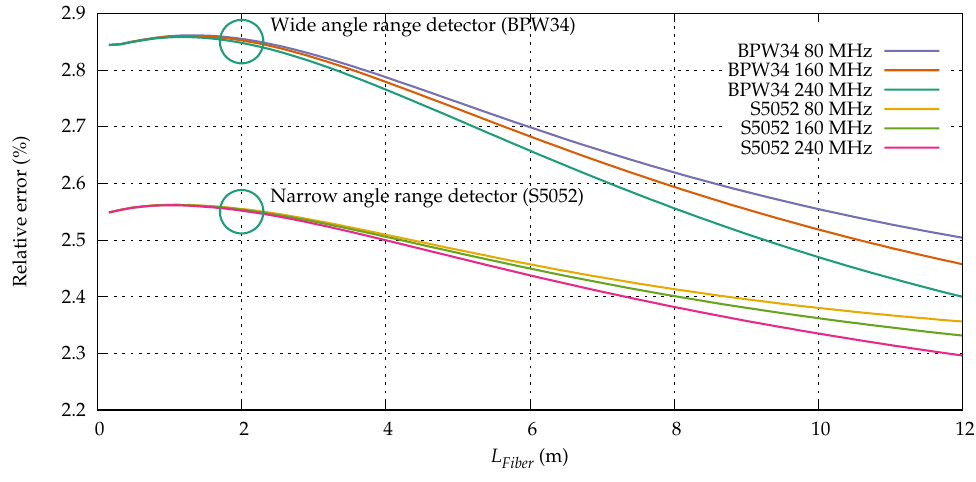
Figure 15. Simulated relative error considering different modulation